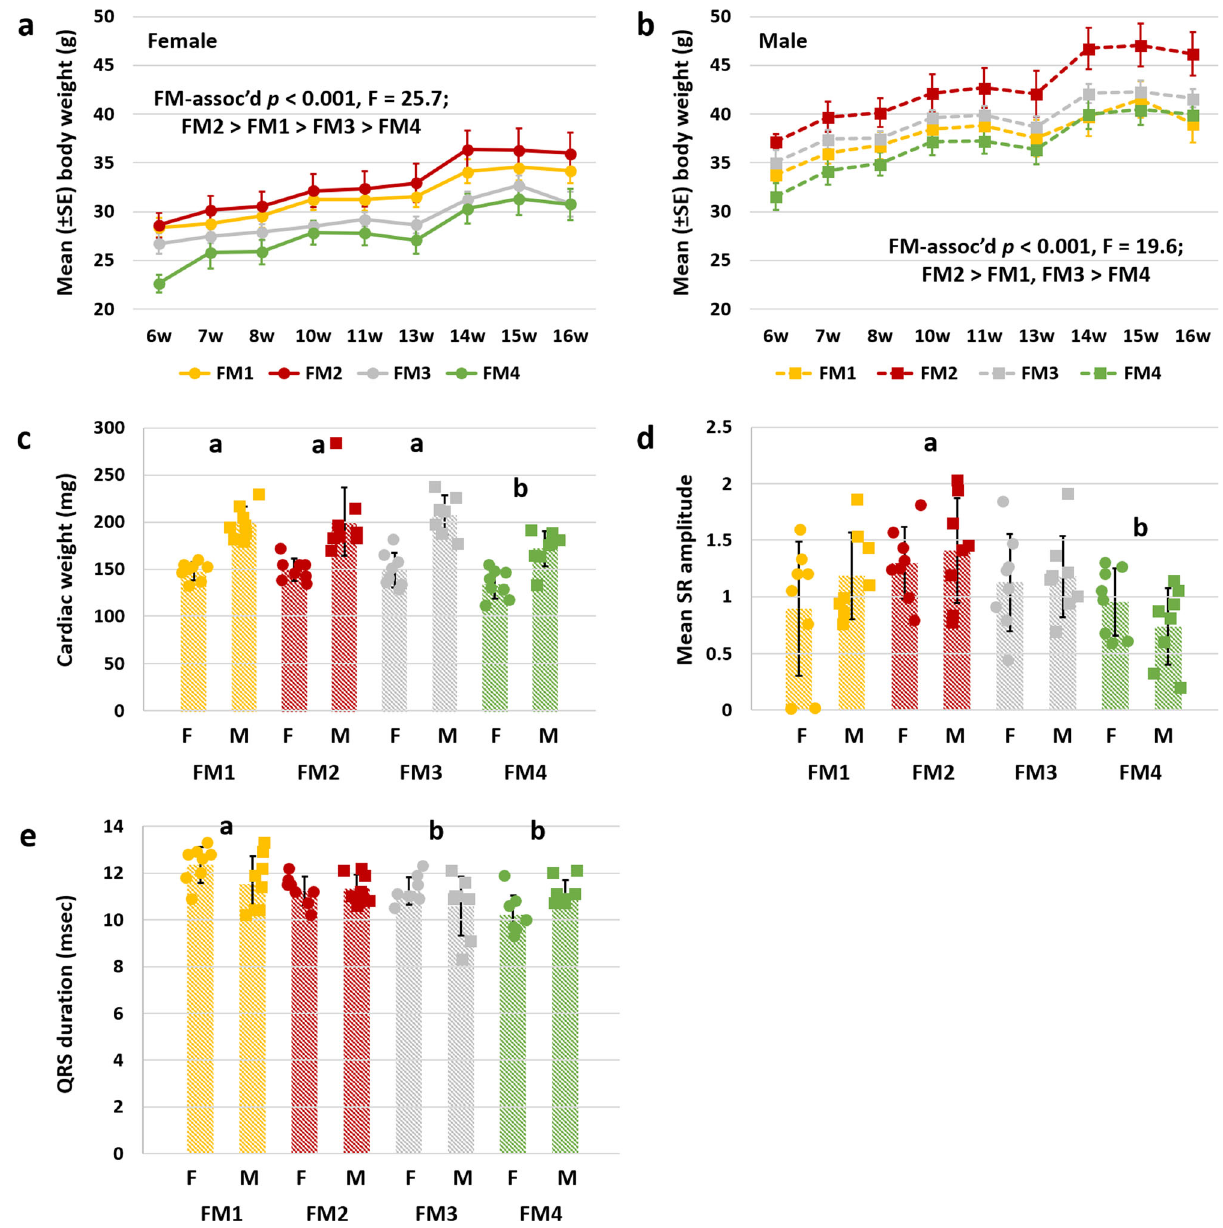
CD-1 mice colonized with FM1, FM2, FM3, or FM4 (legend at bottom), from 6 weeks (6w) to 16 weeks of age. b Line chart showing mean (±SE) body weight of male CD-1 mice colonized with FM1, FM2, FM3, or FM4 (legend at bottom), from 6 weeks to 16 weeks of age. c Dot plot showing cardiac weight at 16 weeks, in female (F) and male (M) mice colonized with FM1, FM2, FM3, or FM4 ( p = 0.003, F = 5.1). d Dot plot showing SR amplitude, measured via ECG, in mice shown in Panels A-C ( p = 0.008, F = 4.3). e Dot plot showing QRS interval, measured via ECG, in mice shown in Panels a – c ( p < 0.001, F